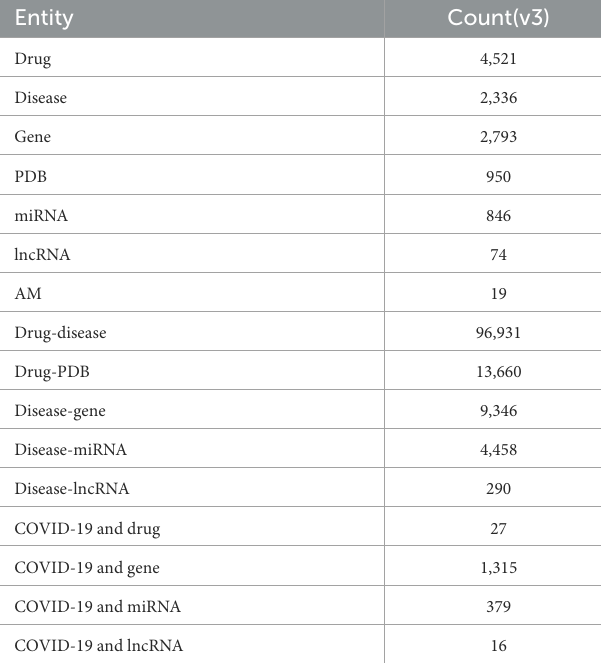
TABLE 1 Summary statistics of the